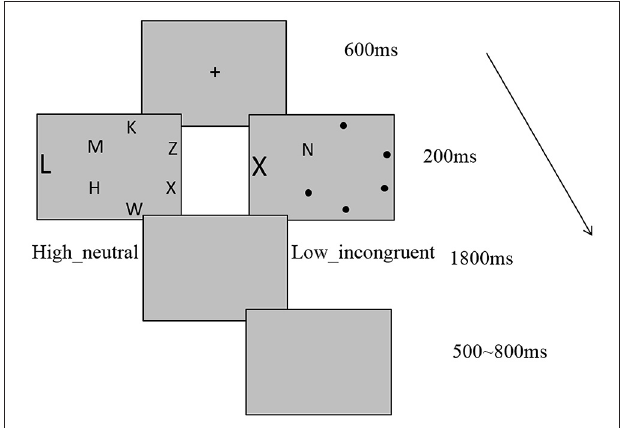
FIGURE 1 | Example of trial sequence and example display with high load neutral and low load incongruent